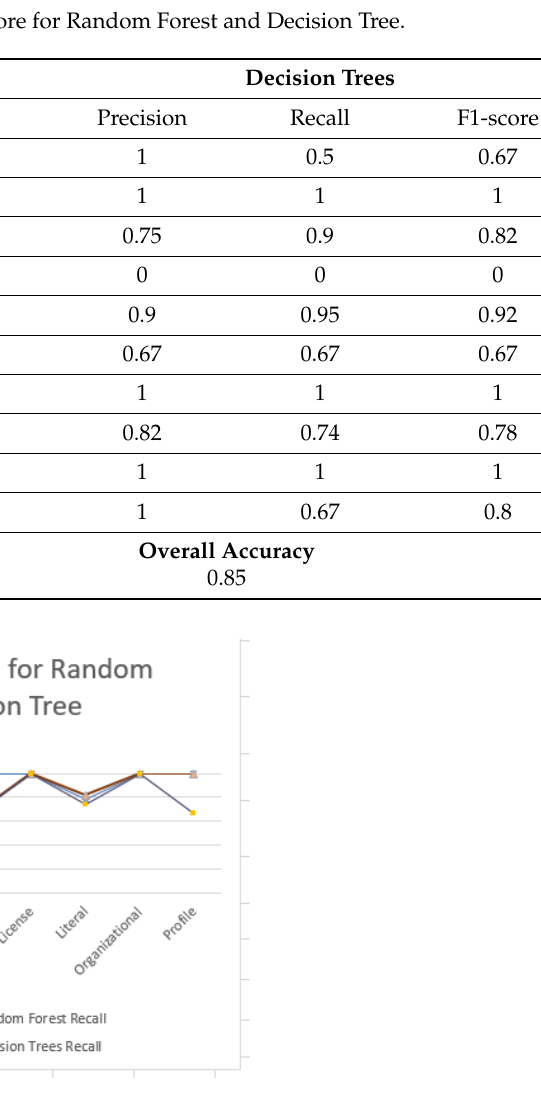
Figure 8. The precision and recall for Random Forest and Decision Tree.